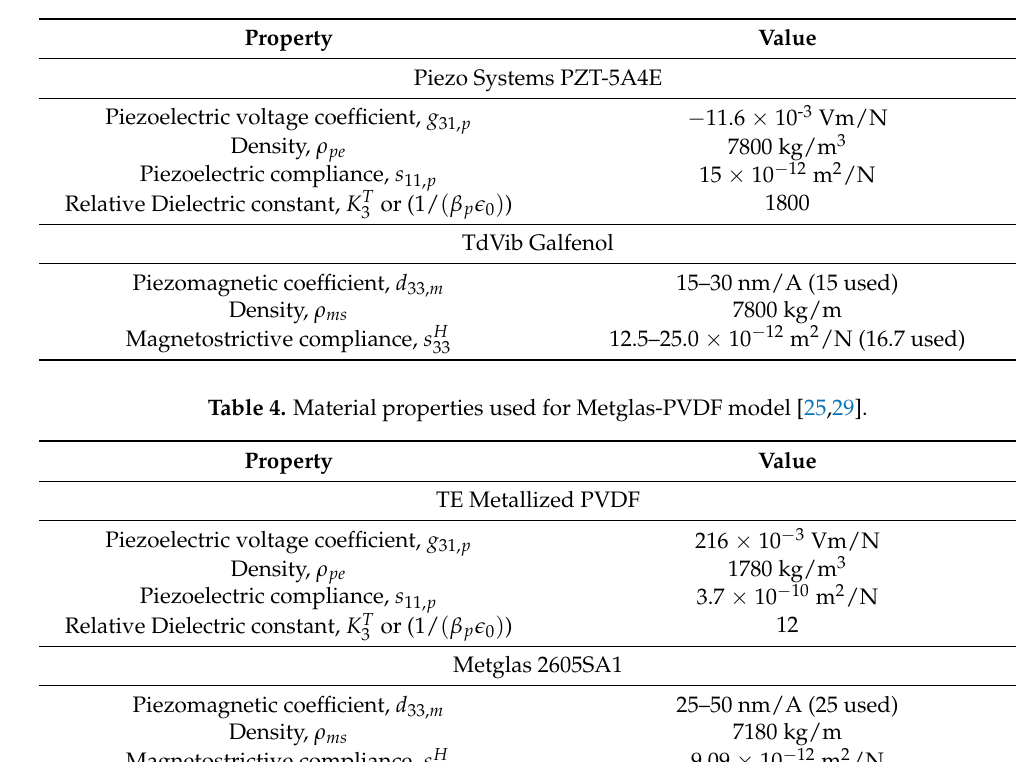
Table 3. Material properties used for Galfenol-PZT laminate model.